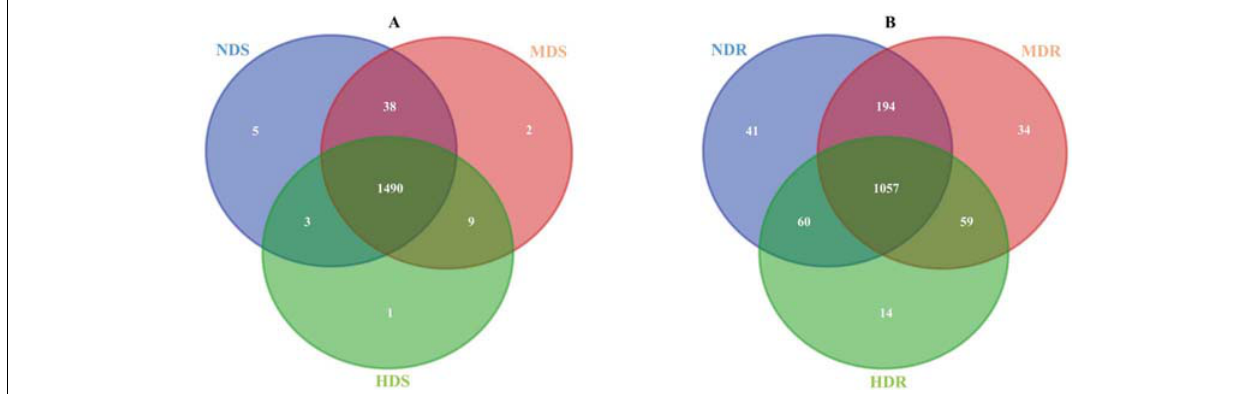
FIGURE 2 | Venn diagram showing the common and unique bacterial operational taxonomic units in soil (A) and root (B) samples collected from the non-diseased (NDS and NDR), moderately diseased (MDS and MDR), and highly diseased (HDS and HDR) sites. TABLE 4 | Alpha diversity indices of soil and root bacterial communities in different konjac growing sites affected by different degrees of soft rot disease. Sample ACE Chao 1 Shannon index Simpson index